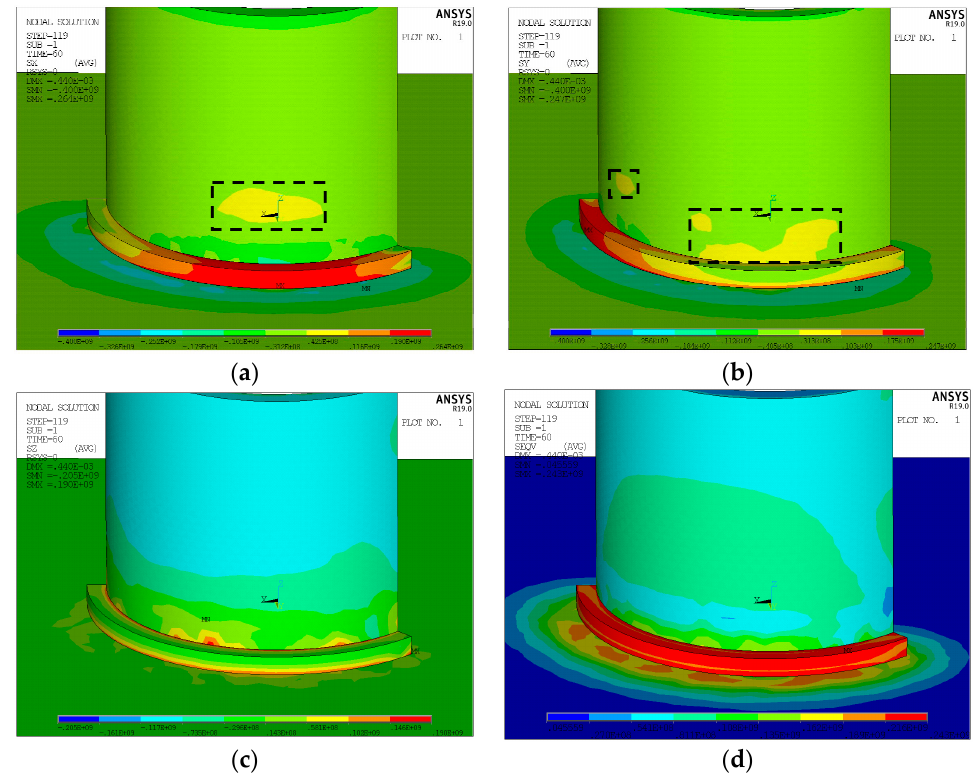
Figure 5. Welding residual stress cloud diagram: ( a ) residual stress along the x-axis; ( b ) residual stress along the y axis; ( c ) residual stress along the z-axis; ( d ) von Mises stress.